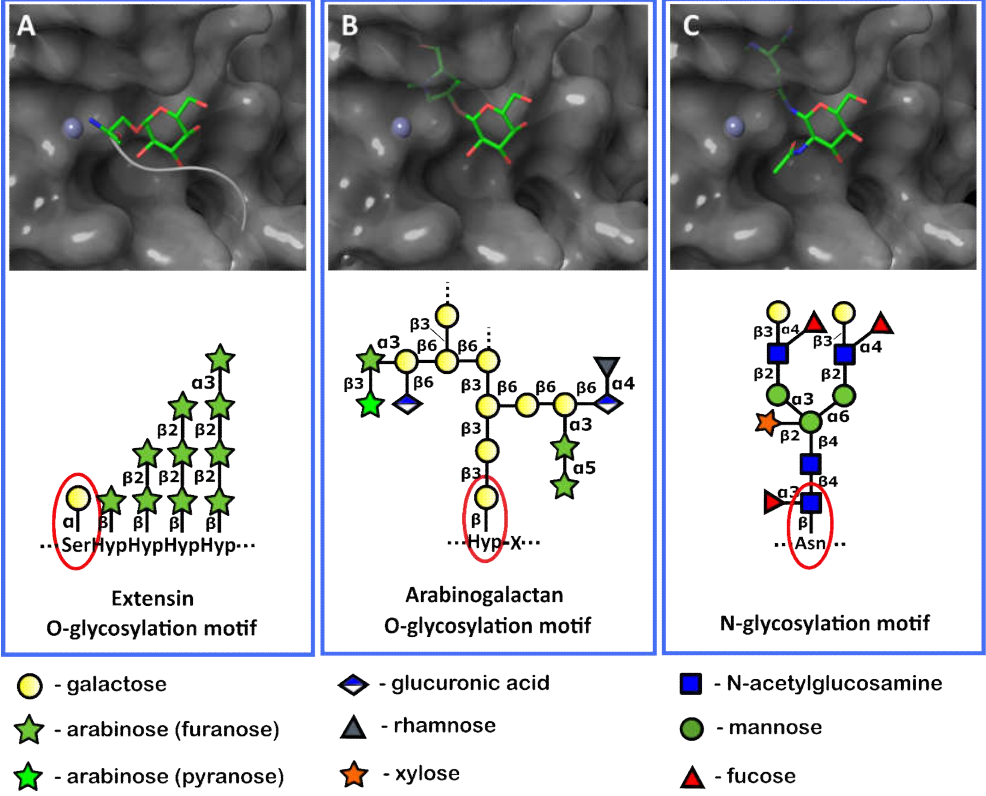
Figure 9. The orientation of the α -glycosylated ( A ) and β -glycosylated ( B , C ) amino acid residues characteristic of the extensin ( A ) or arabinogalactan ( B ) O-glycosylation motifs and plant protein N-glycosylation motif ( C ) in the pocket of the active site of the Svx protein of Pectobacterium atrosepticum . Red ellipses show the sugar residues attached to the amino acid residues in the plant cell wall glycoproteins. These parts of glycoproteins were used as ligands for docking and superposition with the Pba Svx protein.